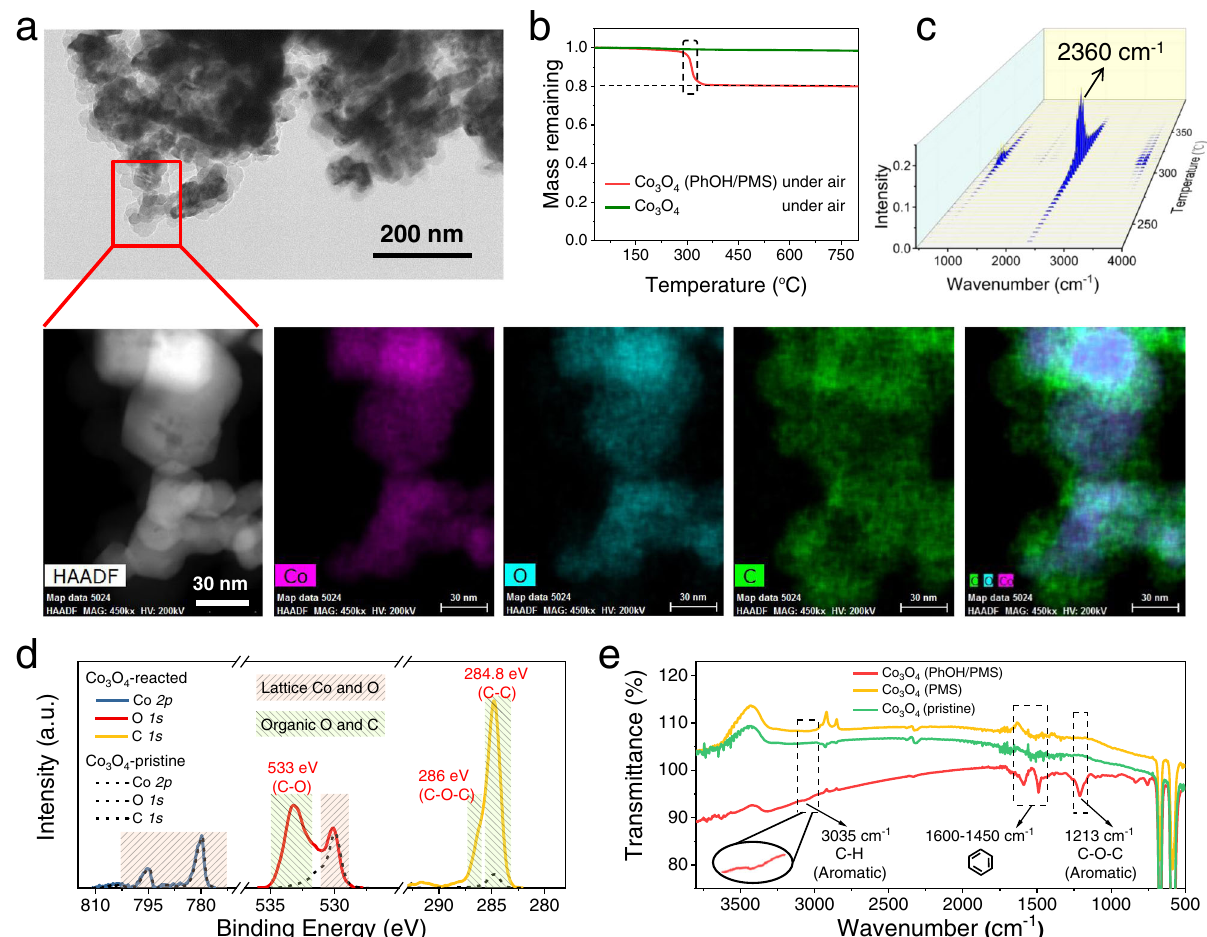
Fig. 2 Product analyses of the model reaction system (Co 3 O 4 /PMS/PhOH). a STEM, HAADF, and EDS elemental mapping images of the Co 3 O 4 after the reaction. b TGA curves of the pristine and reacted Co 3 O 4 in air (O 2 ). The mass loss of 20% for the reacted Co 3 O 4 was equal to the initial concentration ratio of [PhOH] to [PhOH] + [Co 3 O 4 ], which indicates that the pollutant molecules were fully transferred to the catalyst surface. c 3D-FTIR spectra of the gas products detected from TGA of the reacted Co 3 O 4 in b . The decomposition temperature (centered Around 300 °C) in air (O 2 ) and the gas product (CO 2 ) are characteristic of polymers. d , e XPS spectra ( d ) and FTIR spectra ( e ) of the pristine and reacted Co 3 O 4 . The signal intensities in the XPS spectra of the pristine and reacted Co 3 O 4 were normalized by that of Co 2p